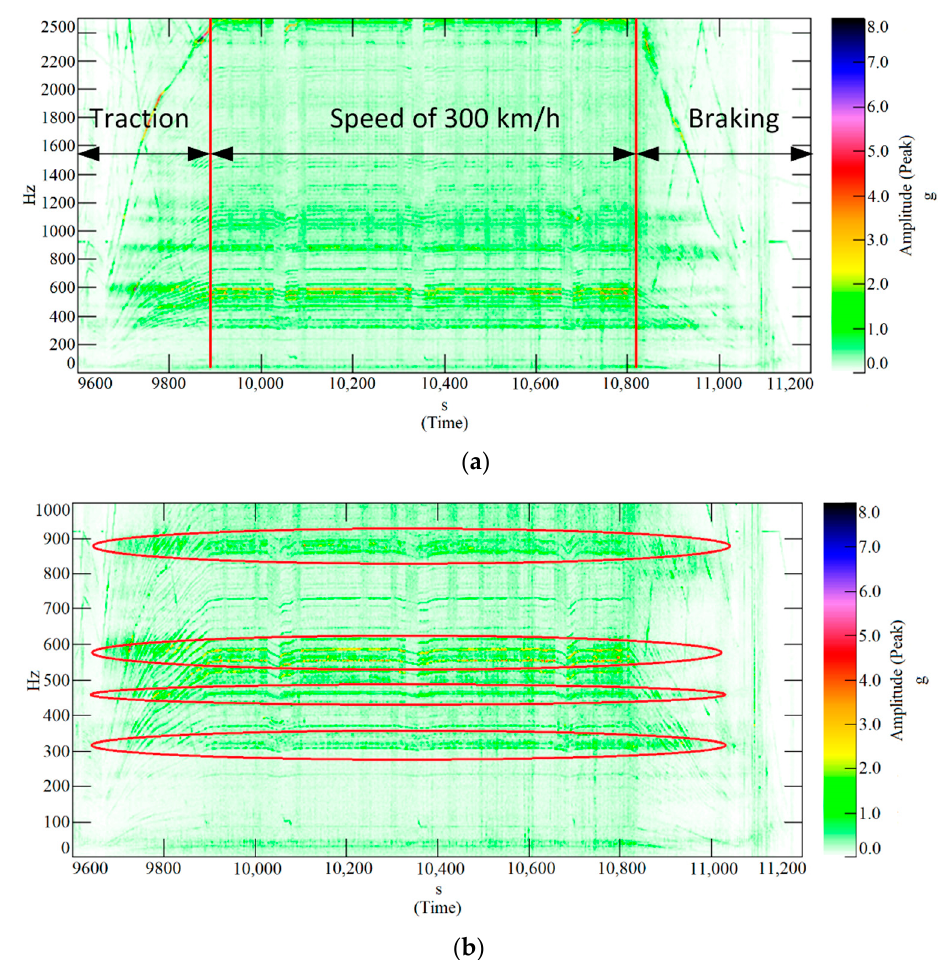
Figure 9. STFT of the vibration acceleration of gearbox in the frequency range of (a) 0~2500Hz (b) 0~1000Hz